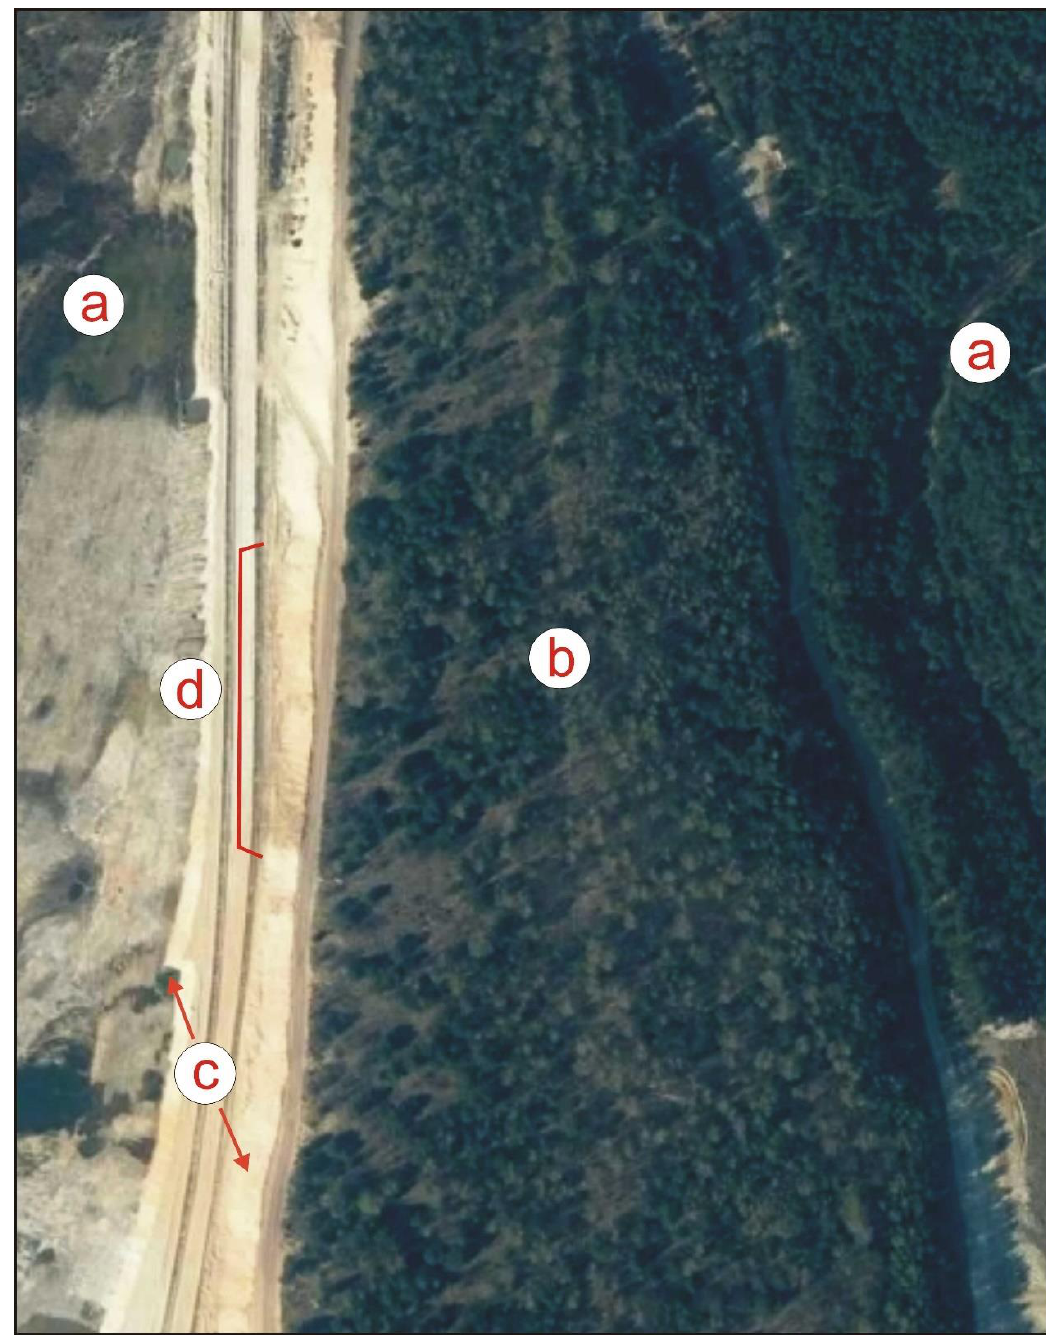
Figure 3. Northern part of the study area (source: e-mapa.net): (a) sand mine pit; (b) inselberg mined for sand — a complex comprising a Vistulian terrace and postglacial formations of the Odra Glaciation; (c) two working wall steps; (d) crumbling hardpan zone.